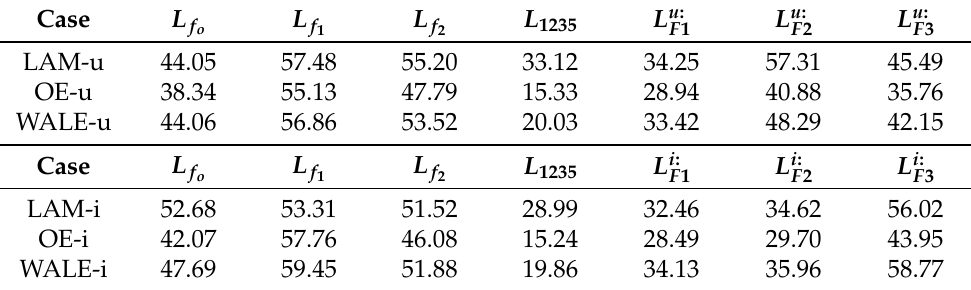
Figure 9. Acoustic sound spectra from the numerical simulation of vocalization of [u:] ( left ) and [i:] ( right ) at monitoring point “MIC 1”. Table 4. Sound pressure levels [dB] at probe MIC 1 for aeroacoustic simulations (vowel u: and i:), based on CFD simulations with the laminar, One-Equation and Wall-Adapting Local Eddy-viscosity (WALE) sub-grid scale (SGS) models. Values at f o = 100 Hz, f 1 = 200 Hz, f 2 = 300 Hz, non-harmonic frequency 1235 Hz and formant